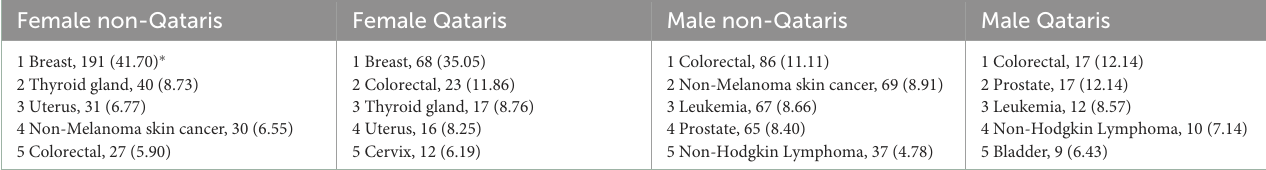
TABLE 4 Most common types of cancers by sex and nationality in Qatar, Qatar National Cancer Registry, 2016. Female non-Qataris Female Qataris Male non-Qataris Male